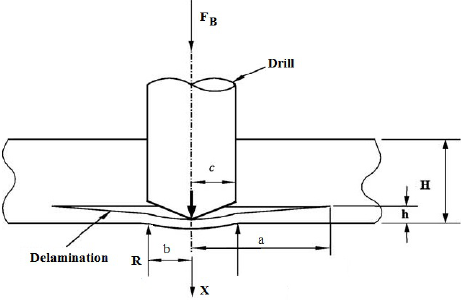
Figure 3. The schematic of delamination for sup- ported drilling.